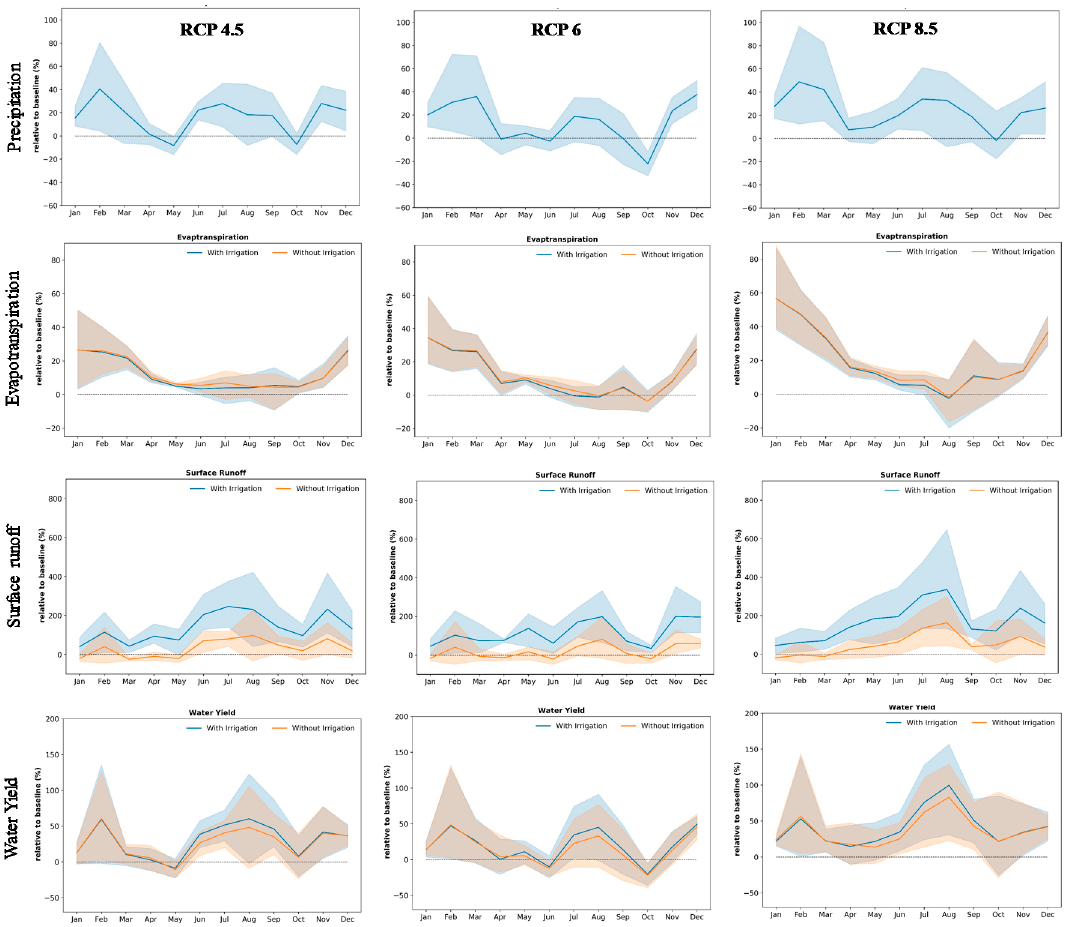
Figure 8. Changes in monthly precipitation, evapotranspiration, surface runoff, and water yield for late-century (2085–2099) under three scenarios: RCP 4.5, RCP 6, and RCP 8.5. The results are presented as the relative percentage change compared to the baseline period (1986–2000).